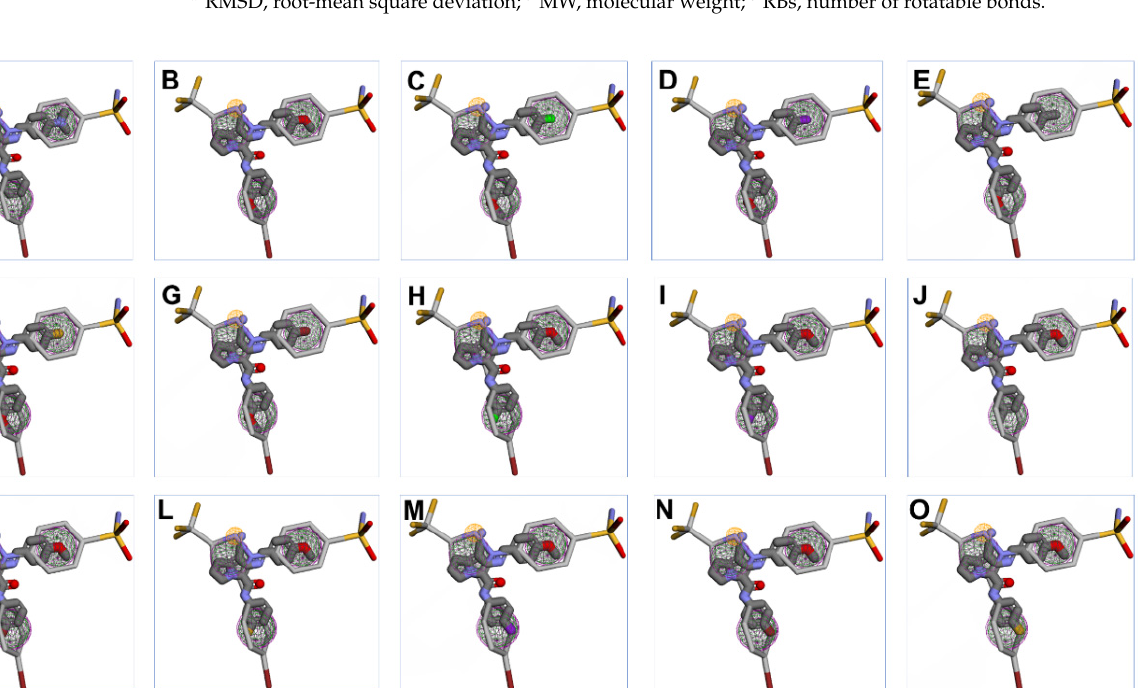
CH 3 , F, and Br. On the other hand, the substituents of phenyl ring (B) were in the following order: N(CH 3 ) 2 , OCH 3 , Cl, I, CH 3 , F, and Br, Figure 7.